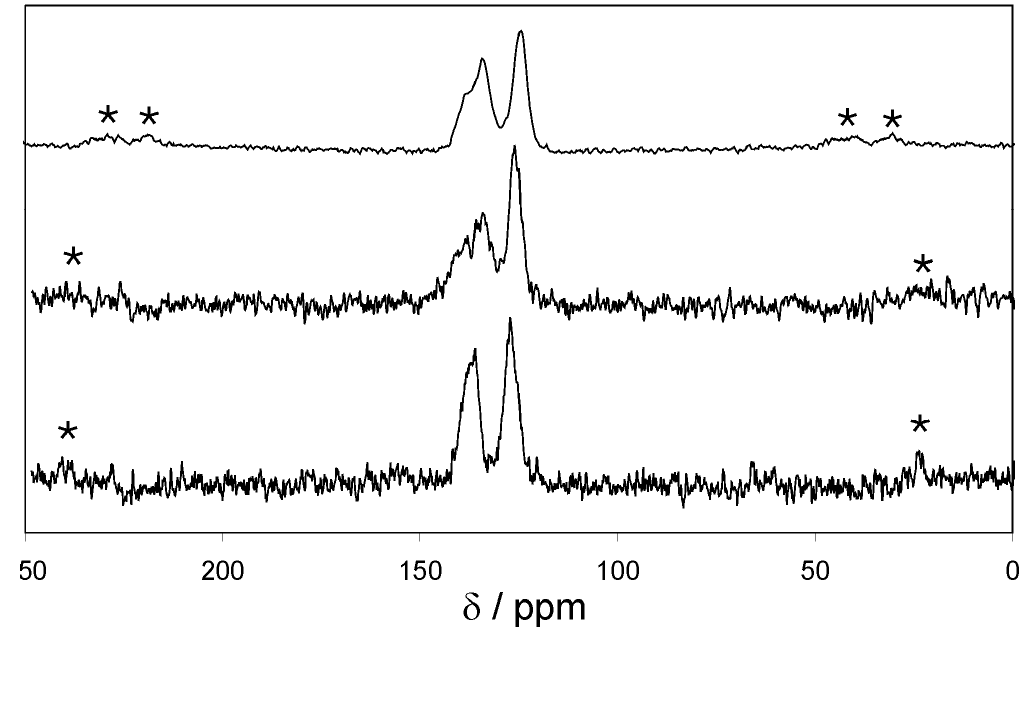
Figure 3. 13 C CP MAS NMR spectra of EOF-3 (top), -4 (middle), and -5 (bottom) (* spinning